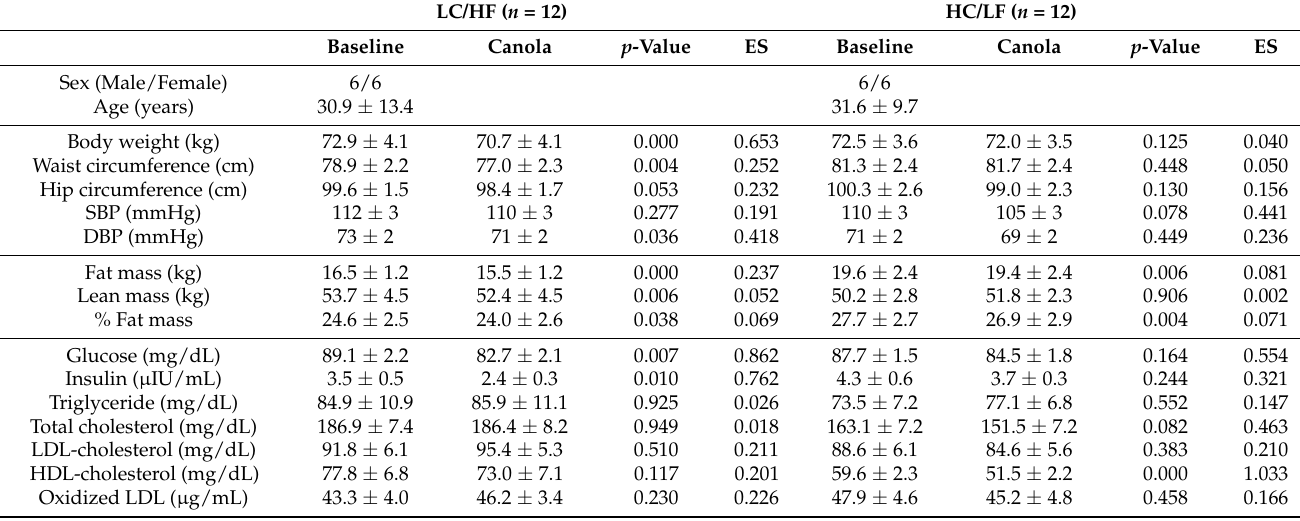
Table 2. Baseline and Canola Oil (Run-In) Diet responses in the low-carbohydrate/high-fat (LC/HF) and high- carbohydrate/low-fat (HC/LF)